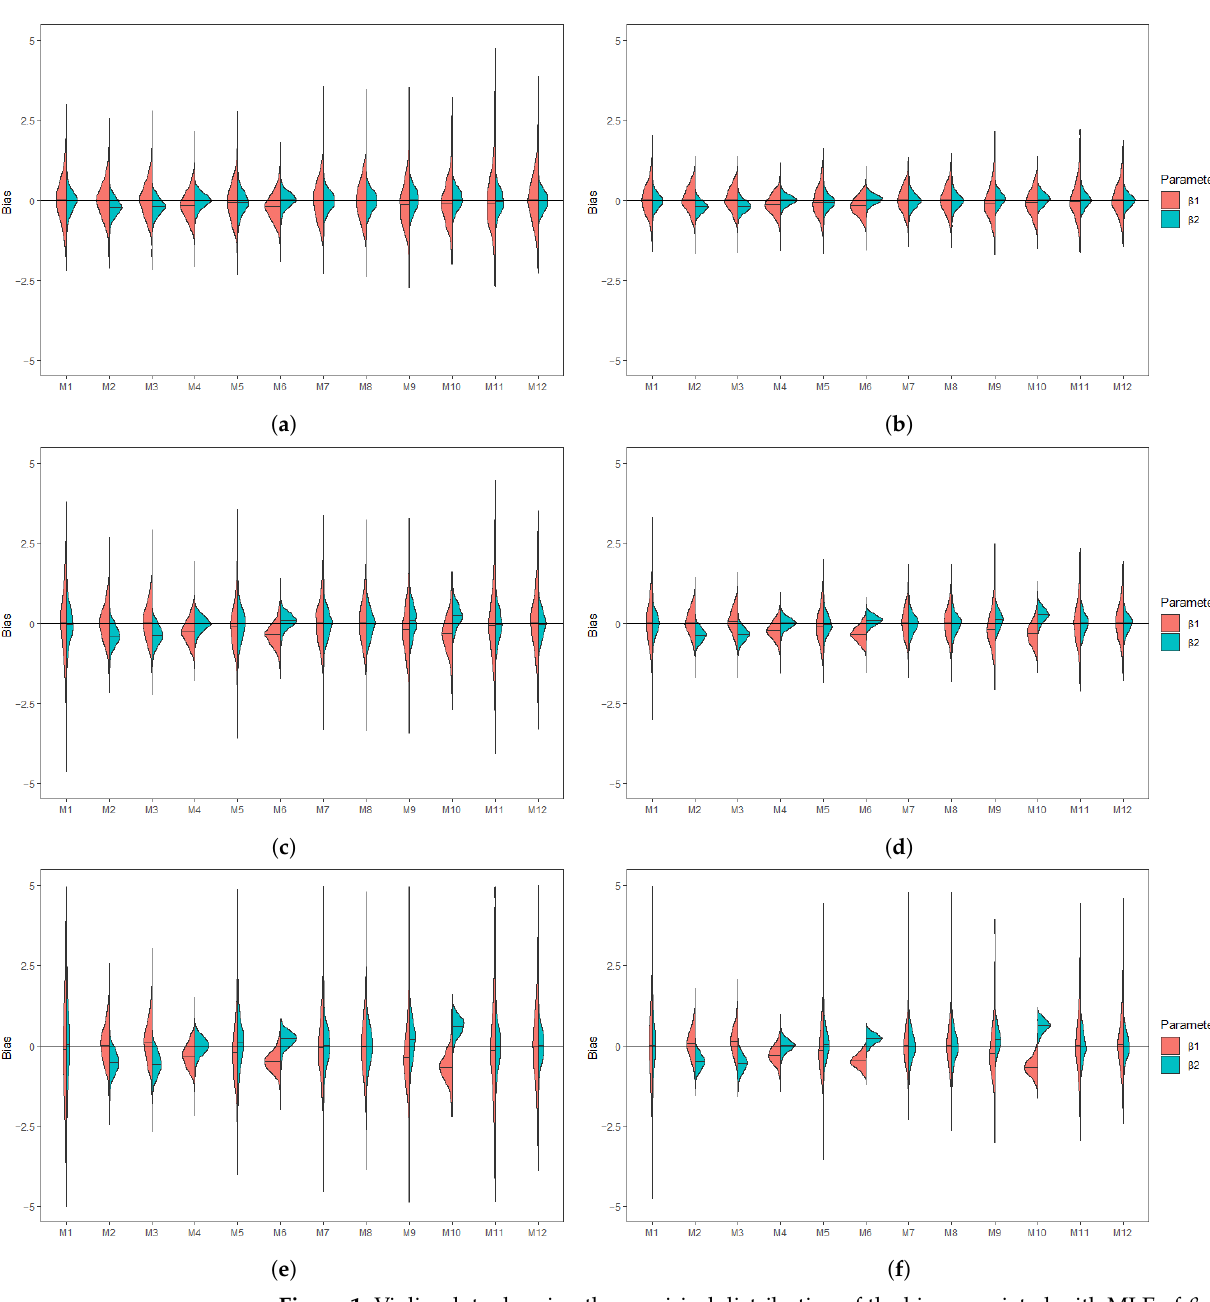
Figure 1. Violin plots showing the empirical distribution of the bias associated with MLE of β 1 (red) and β 2 (green) when covariates are independent and X ∗ , j = 1,2 is subjected to lower LOD. ( a ) Bias ij under n = 50 and m 1 = m 2 = 20%. ( b ) Bias under n = 100 and m 1 = m 2 = 20%. ( c ) Bias under n = 50 and m 1 = m 2 = 40%. ( d ) Bias under n = 100 and m 1 = m 2 = 40%. ( e ) Bias under n = 50 and m 1 = m 2 = 60%. ( f ) Bias under n = 100 and m 1 = m 2 =